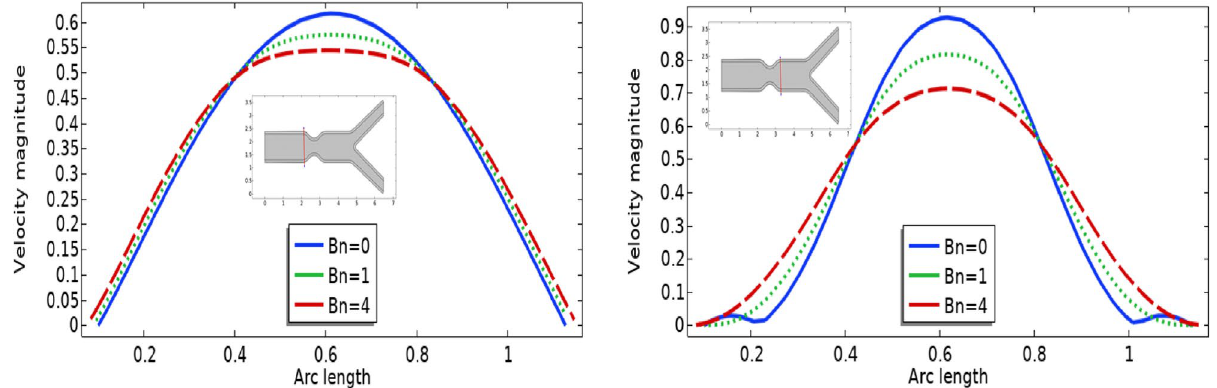
Figure 7. Velocity profile for different